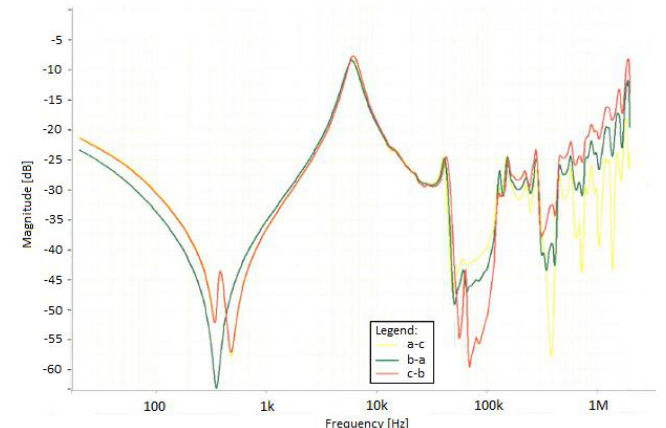
Figure 6. Results of the sweep frequency response analysis (SFRA) measurements for tertiary windings in an open system.